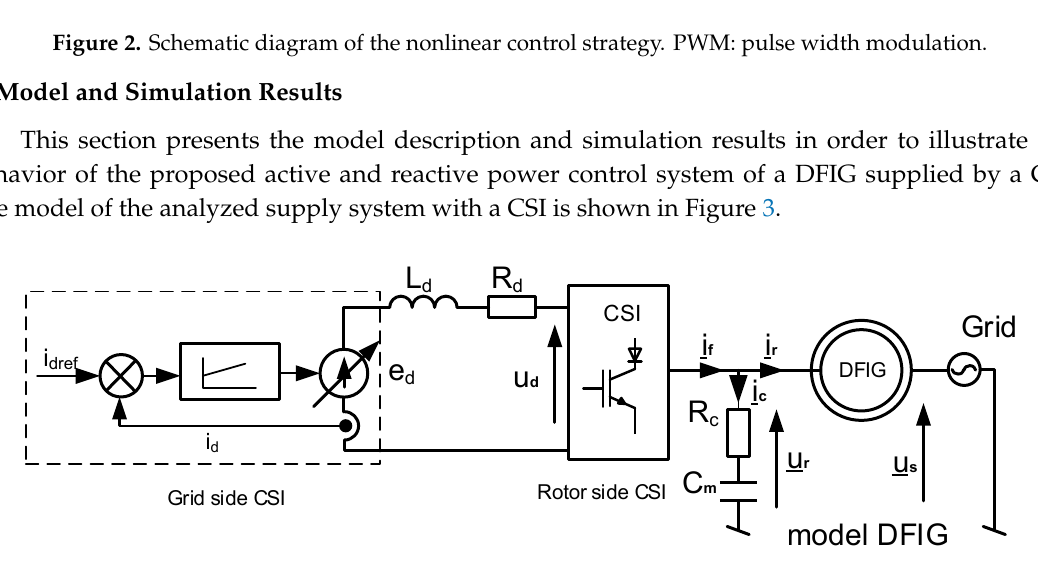
Figure 3. Model of the DFIG rotor supply system with a CSI.